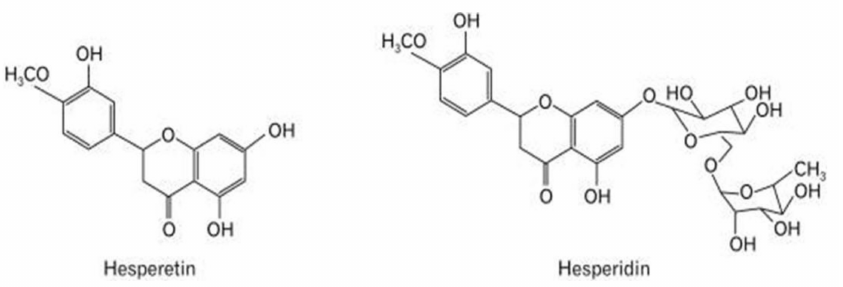
Figure 5. Chemical structure of hesperidin and hesperetin [95]. H 3 CO, methoxy group; CH 3 , methyl